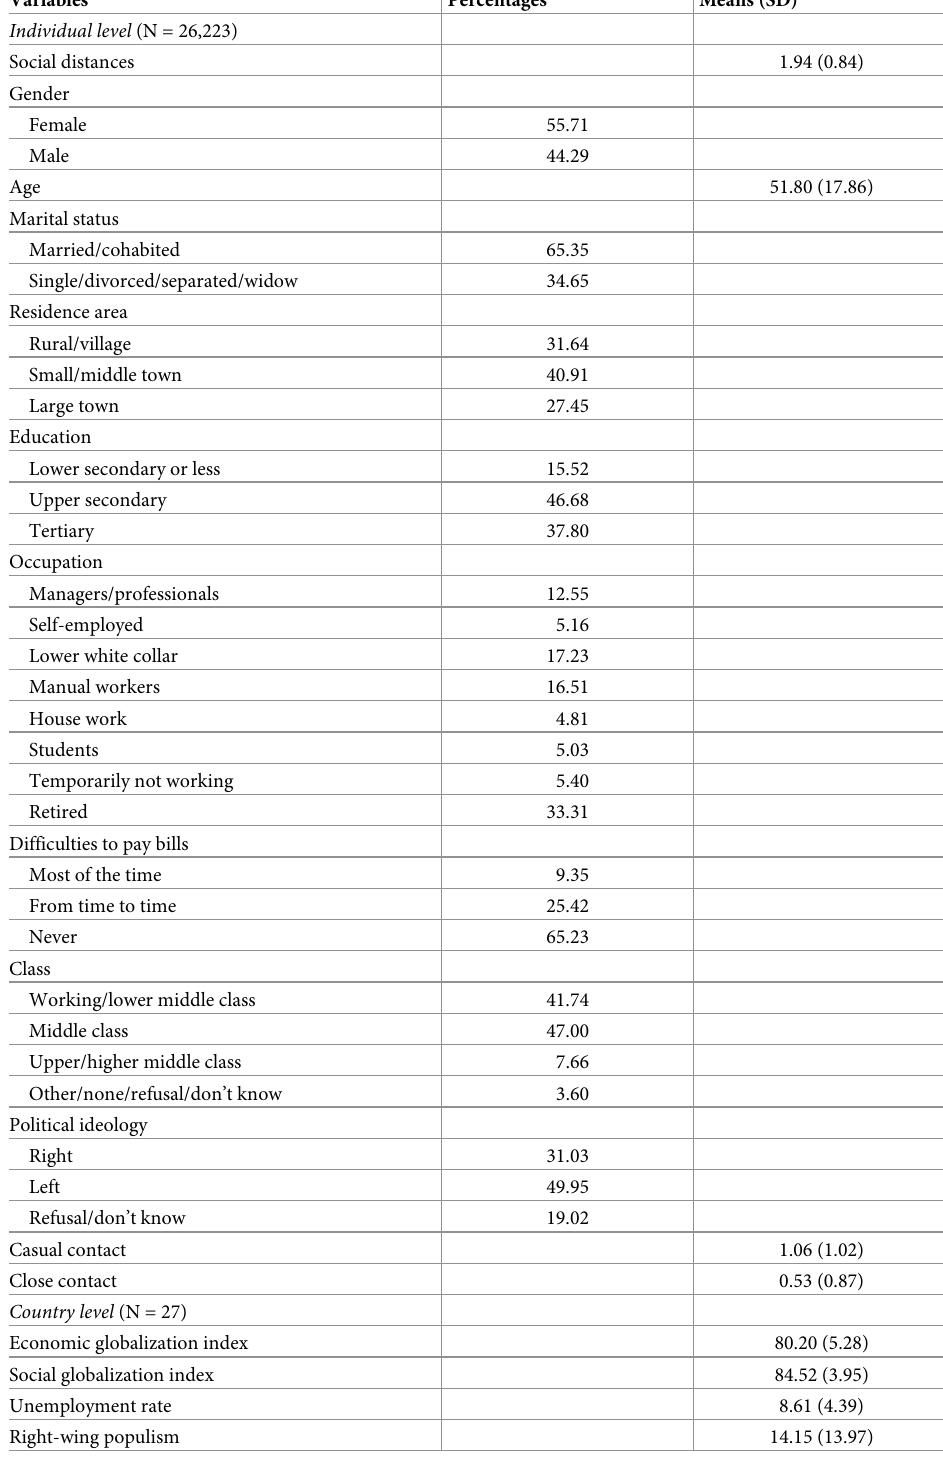
Table 1. Summary